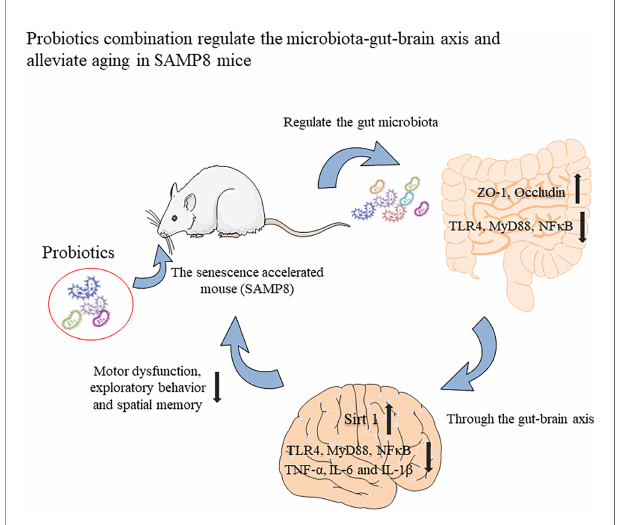
FIGURE 7 | Graphical summaryofthis study.The probioticcombination, determined byscreeningthe faeces of centenarians, can increase the expression of intestinal permeability-relatedproteins ZO-1 andOcculdin byregulating the intestinal microbiota. It also inhibits TLR4/NF k B-induced intestinal in fl ammation andthen inhibits TLR4/NF k B-induced neuroin fl ammation throughthe gut-brain axisand up-regulates the expression of Sirt 1 to protect hippocampal neurons. These changes underliethe improved spatial memory, motorfunction,and exploratory behaviour of aging